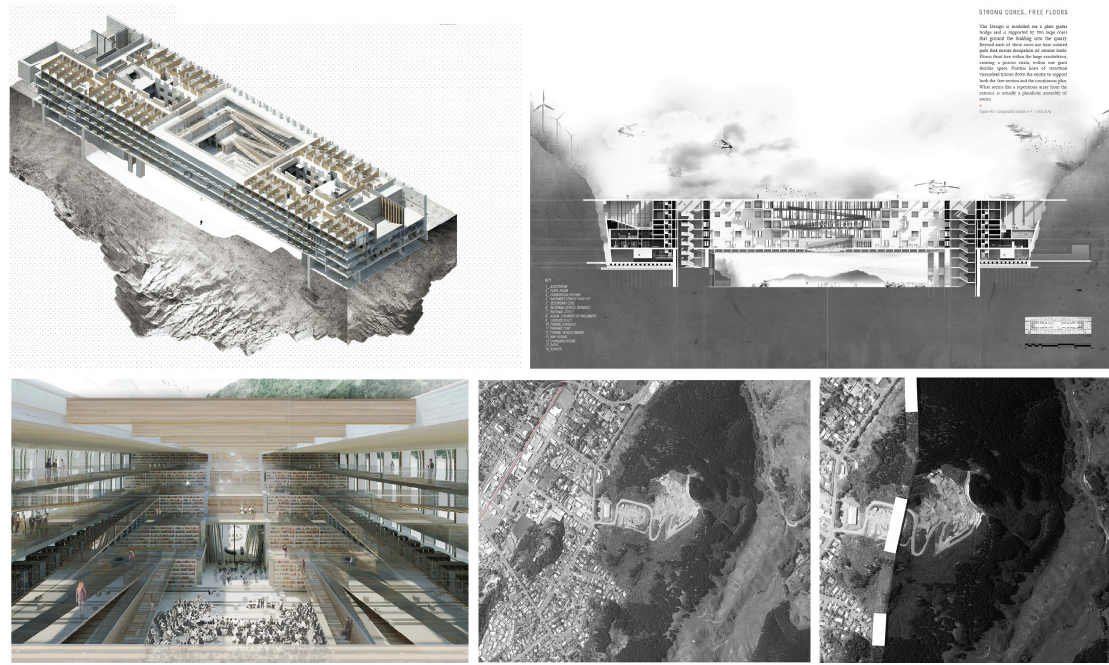
Figure 5. Plan B hive , a speculative design by Ben Allnatt. Anticlockwise from top: axonometric of built form with roof cut away; interior view of flexible space; aerial view of site at edge of low density suburbia; proposed site plan with a series of institutional buildings engaging the edge of suburbia; section through proposed building. Source: Ben Allnatt .